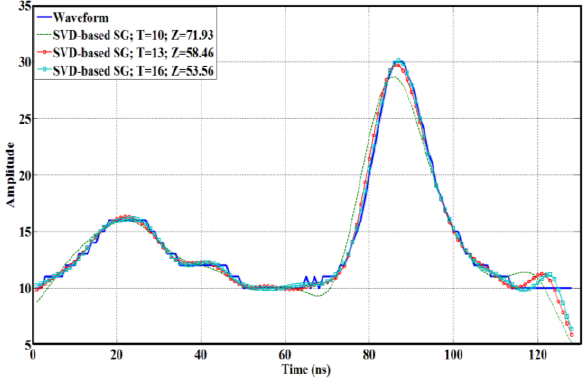
Figure 2. Influences of setting different thresholds (T) in singular values for three cost function values